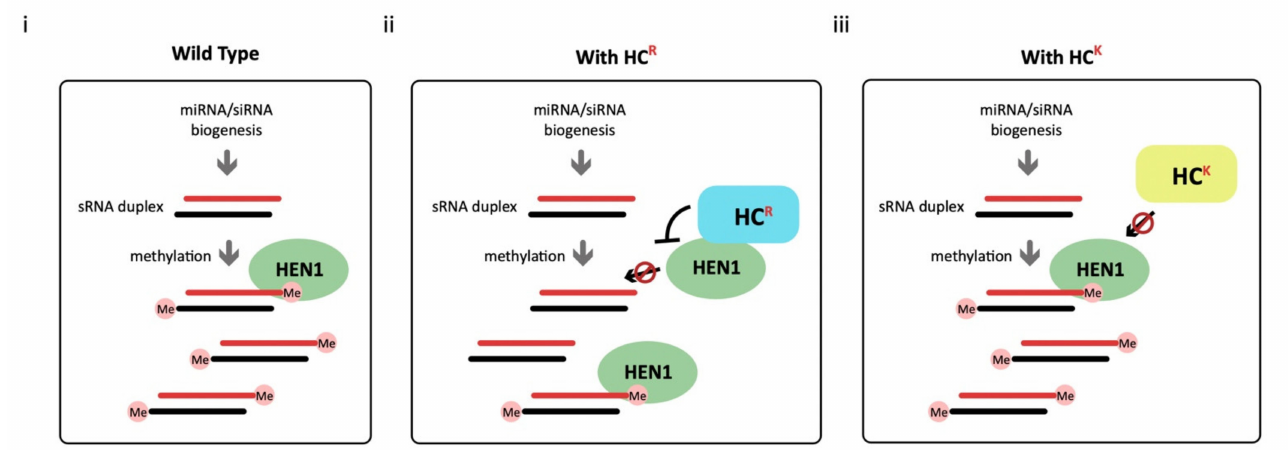
Figure 10. The working hypothesis for TuMV HC-Pro-mediated HEN1 inhibition for RNA silencing suppression in ( i ) wild-type healthy plants, ( ii ) TuGR-infected plants, and ( iii ) TuGK-infected